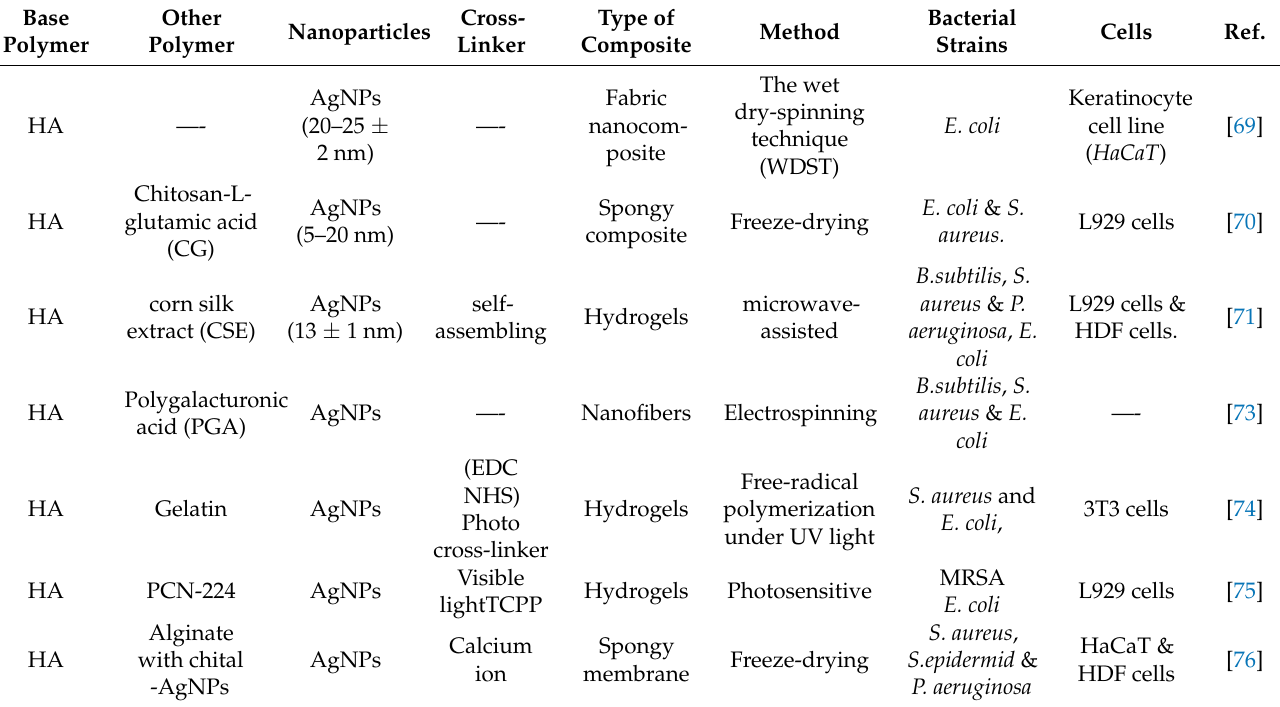
Figure 3. Summary of the AgNPs formation to words bacterial killing for wound healing. Copyright 2017, Elsevier [70]. Table 2. HA-based Ag nanoparticles for wound healing